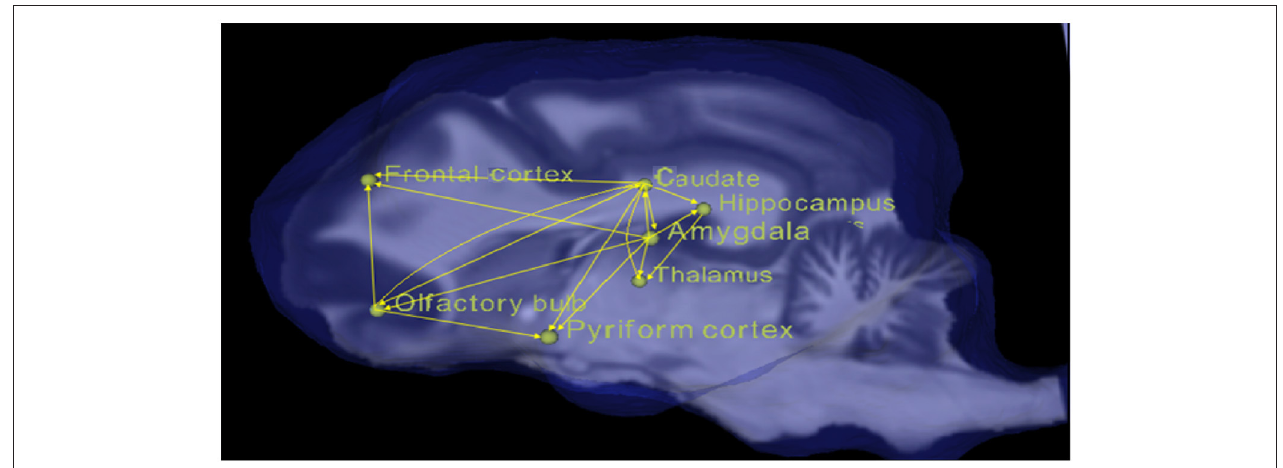
FIGURE 3 | Pictorial depiction of paths with significant increase in connectivity strength for the condition of odorant + zinc nanoparticles (OZ) compared to conditions of odorant (O), water vapor + zinc nanoparticles (WZ), and water vapor alone (W).